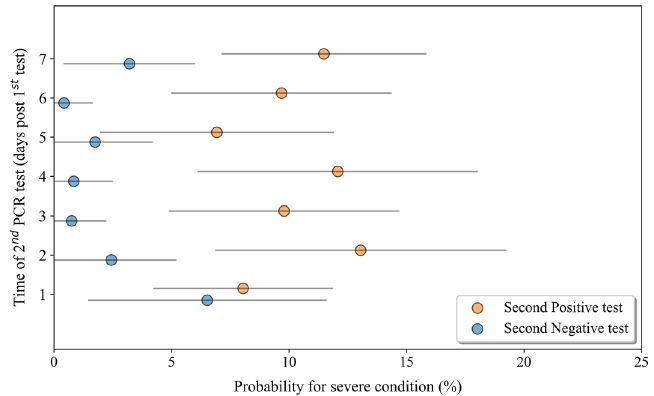
Figure 5. Mapping the best timing to perform the second NP PCR test to assess risk for disease deterioration following COVID-19 diagnosis. Probability for deterioration to severe COVID-19 in SARS-CoV-2 positive individuals who tested a second time within the first week following their diagnosis. Adult patients were stratified according to the day in which the second test was performed during the first week post diagnosis. Blue circles represent individuals who tested negative and orange circles represent individuals who tested positive. Grey lines indicate 95% confidence